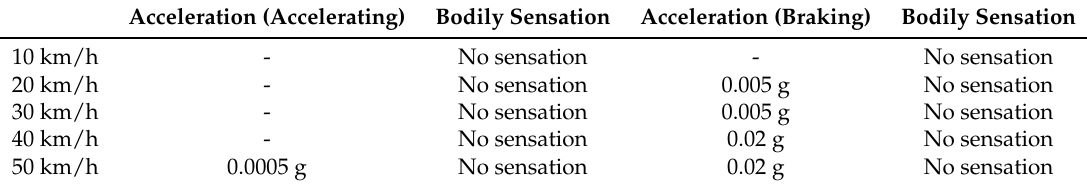
Table 4. Acceleration at different speeds.